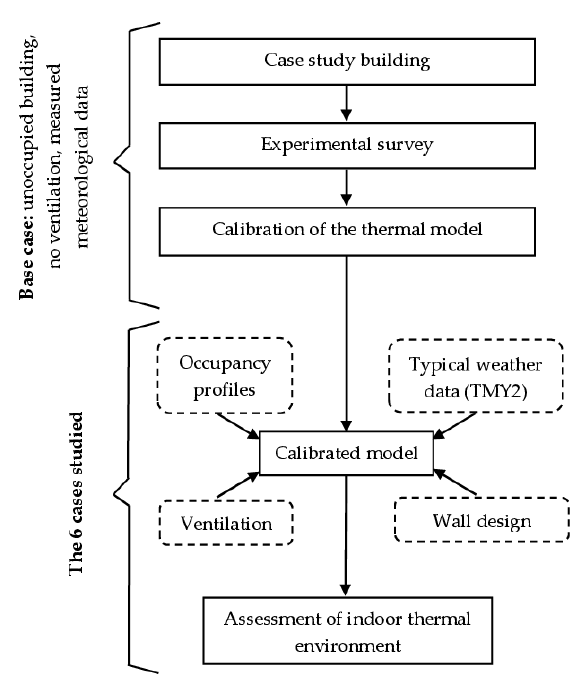
Figure 6. Methodological approach of the study.